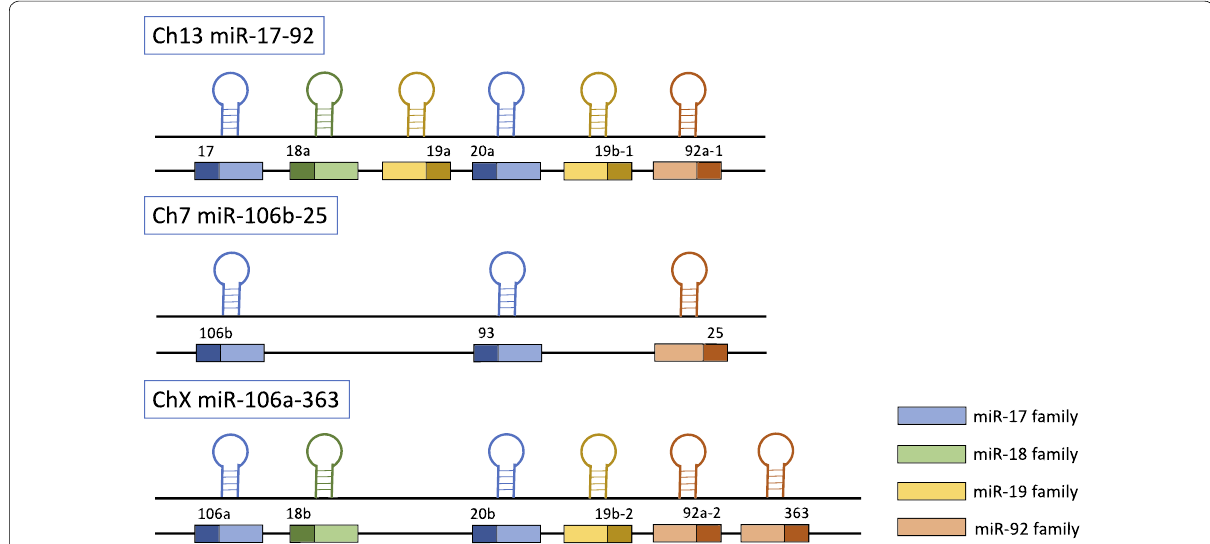
Fig. 1 The human miR-17-92 gene and its homologs. The gene structure of the human miR-17-92 cluster (located on chromosome 13) and its two mammalian paralogs: the miR-106b-25 cluster (located on human chromosome 7) and the miR-106a-363 cluster (located on the X chromosome). The miRNAs encoded by the 3 clusters are categorized into the miR-17 family (miR-17, miR-20a, miR-106b, miR-93, miR-106a and miR-20b), the miR-18a family (miR-18a and miR-18b), the miR-19 family (miR-19a, miR-19b-1 and miR-19b-2) and the miR-92 family (miR-92a-1, miR-25, miR-92a-2 and